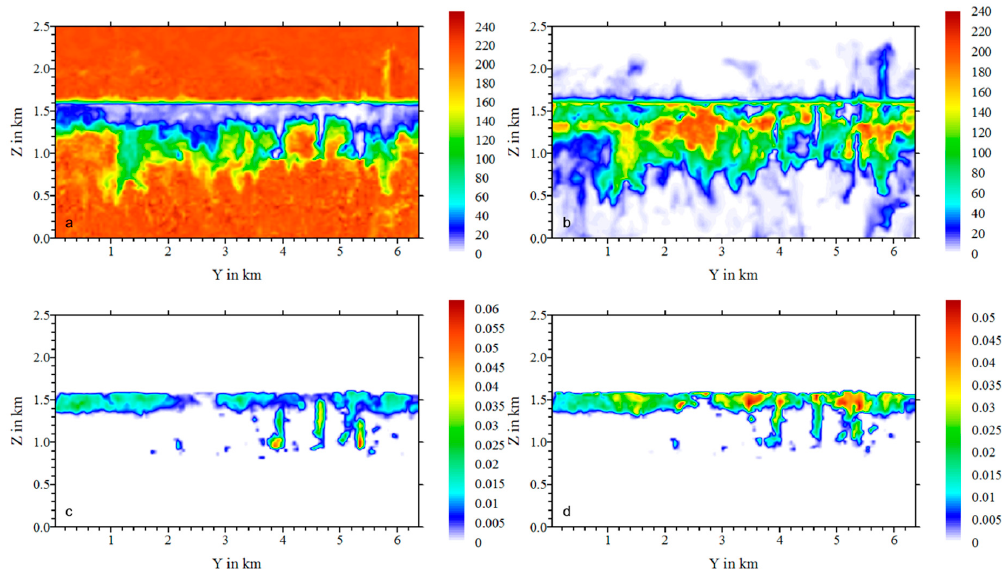
Figure 6. Vertical cross section of ( a ) the number of “pristine” aerosol particles (cm − 3 ), ( b ) the number of “processed” aerosol particles (cm − 3 ), ( c ) the “pristine” aerosol particle mass in drops (µg m − 3 ) and ( d ) the “processed” aerosol particle mass in drops (µg m − 3 ) after 240 min along the cross section indicated in Figure 3 and projected onto the Y-axis.